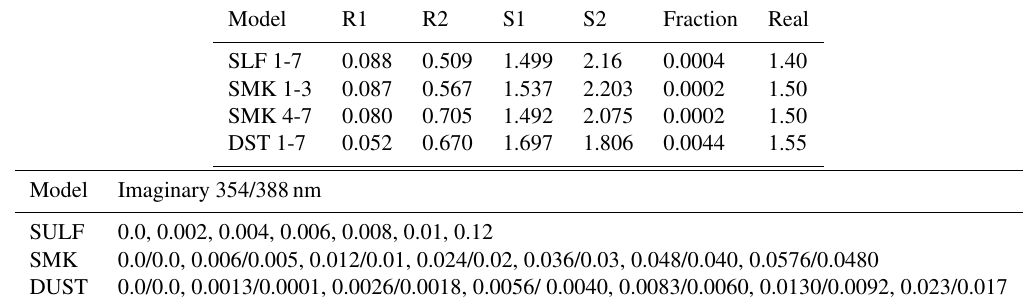
Table 1. Number particle size bi-lognormal distribution parameters and real refractive index for the aerosol types (sulfate is denoted by SLF, biomass burning by SMK) assumed in the OMI near-UV algorithm. Number particle size distribution parameters: fine- and coarse-mode radii (R1, 2) and variance (S1, 2), coarse-mode fraction. The bottom table list nodal points in imaginary refractive index (wavelength-independent for the sulfate and spectrally dependent for smoke and desert dust aerosols) (adapted from Torres et al., 2007; Jethva and Torres, 2011). Model R1 R2 S1